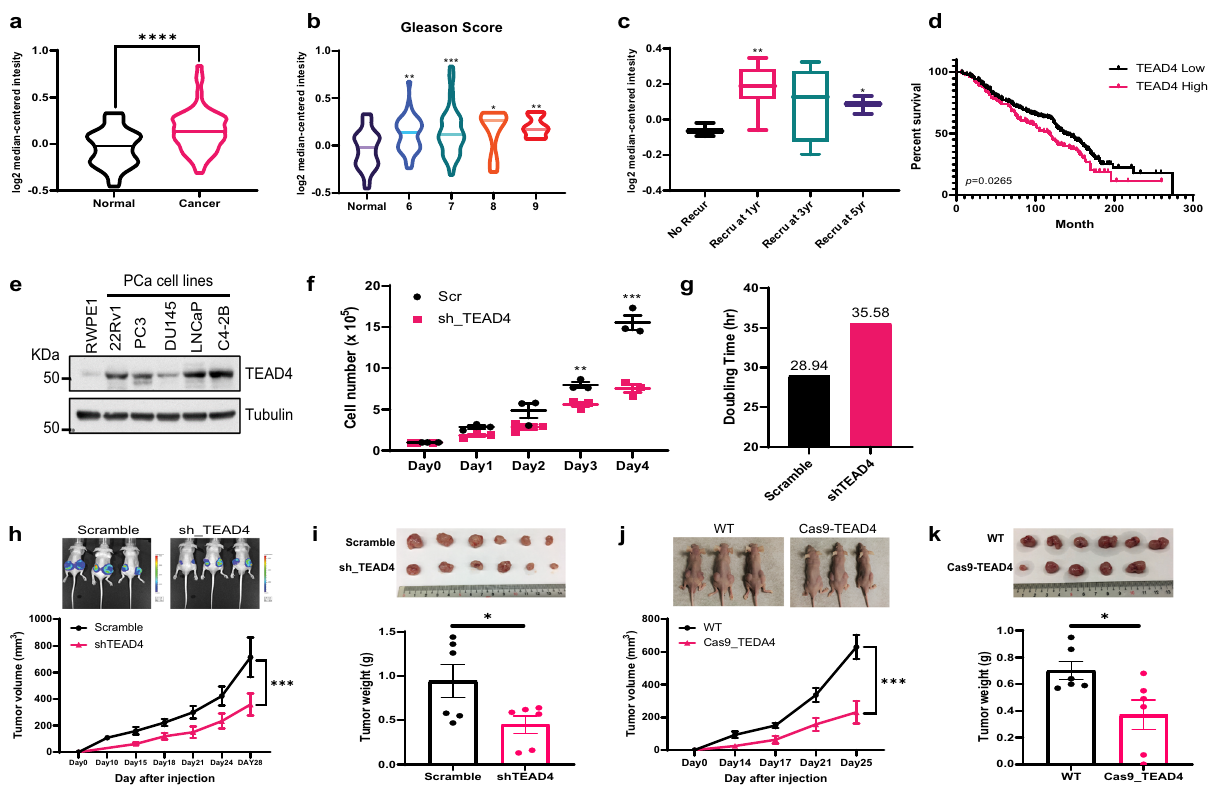
Fig. 7 TEAD4 could be a potential target for cancer therapy. a TEAD4 expression in Oncomine (www.oncomine.org) Taylor prostate cancer database ( n for normal = 29, n for cancer = 131, the center line indicates median, **** p < 0.0001). b Association of TEAD4 expression with Gleason score in Oncomine (www.oncomine.org) Taylor prostate cancer database ( n for normal = 25, n for Grade 6 = 41, n for Grade 7 = 74, n for Grade 8 = 8, n for Grade 9 = 7, the center line indicates the median, * p < 0.05, ** p < 0.01, *** p < 0.001). c Correlation of TEAD4 expression with tumor recurrence in Oncomine (www.oncomine.org) Taylor prostate cancer database ( n for no recurrence = 3, n for recurrence at fi rst year = 9, n for recurrence at third year = 11, n for recurrence at fi fth year = 3, whiskers = min to max, bounds of box = lower quartile and upper quartile, the center line indicates the median, * p < 0.05, ** p < 0.01). d Kaplan – Meier survival plot shows the correlation of TEAD4 expression with survival rate in Oncomine (www.oncomine.org) Setlur prostate cancer database ( n for low expression = 243, n for high expression = 119). e TEAD4 expression in immortalized prostate cell line, RWPE1, and prostate cancer cell lines, CWR22Rv1, PC3, DU145, LNCaP, and C4-2B. f 1 × 10 5 of scrambled shTEAD4 cells were plated in 24-well plate. Cell growth after silencing of TEAD4 by shRNA in CWR22Rv1 cells. g Doubling time after silencing of TEAD4 by shRNA in CWR22Rv1 cells. h Tumor growth curve of silencing of TEAD4 by shRNA in CWR22Rv1 cells and tumor image by IVIS scan at endpoint. i Isolated tumor image and weight at endpoint. j Tumor growth curve of knockout of TEAD4 by CRISPR-Cas9 in CWR22Rv1 cells and tumor image at endpoint. k Isolated tumor image and weight at endpoint. Data are presented as mean value ± SEM of independent experiments ( n = 3 in f , n = 6 in h – k ). * p < 0.05, ** p < 0.01, *** p < 0.001, **** p < 0.0001, using unpaired two-tailed Student ’ s t test. Source data are provided as a Source data fi changes were identi fi ed by pairwise comparison analyses ( ≥ 1.5-fold threshold), and arginine-stimulation experiment, L-Arginine (200mg/ml) was freshly added after expression patterns were analyzed by hierarchical clustering. overnight arginine starvation. Cells were routinely tested for mycoplasma con- tamination using a PCR-based detection analysis (e-Myco #25233). Antibodies . TEAD4 (#ab58310), pan-OXPHOS (#ab110413), and Ki67 (#ab15580) were purchased from Abcam. p-mTOR (T2446) (#09-345) and acetyl-histone H3 (#06-599) were purchased from Millipore. Phosphor-PGC1a (#AF6650) was pur- chased from R&D. mTOR (#2938), p-mTOR (S2448) (#5536), YAP (#14074), p-YAP (S127) (#13008), p-YAP(S397) (#13619), p38 (#8690), p-p38 (T180/182) (#4511), acetyl-histone H3 (Lys9) (#9649), acetyl-histone H3 (Lys14) (#7627), acetyl-histone H3 (Lys18) (#13998), acetyl-histone H3 (Lys27) (#8173), acetyl-histone H3 (Lys56) (#4243), histone H3 (#4499), acetyl-histone H2A (Lys5) (#2579), acetyl-histone H2B (Lys5) (#12799), histone H2A (#12349), histone H2B (#12364), acetyl-histone H4 (Lys5) (#8647), acetyl-histone H4 (Lys8) (#2594), acetyl-histone H4 (Lys12) (#13944), acetyl-histone H4 (#2935), PGC-1a (#2178), p21 (#2974), and p27 (#83630) were purchased form Cell Signaling. All antibodies were used at a dilution of 1:1000 for immunoblotting and 1:250 for immuno- fl uorescent staining. Microarray assay . After arginine-stimulation treatment, the total RNA was extracted from the CWR22Rv1 cells by the RNeasy Mini Kit (Qiagen) according to the manufacturer ’ s instructions. Microarray gene expression pro fi ling was per- formed by the Transcriptome Analysis Console software (Thermo fi sher, Version 4.0) with Affymetrix GeneChip Human Clariom ™ S Assay. The gene expression